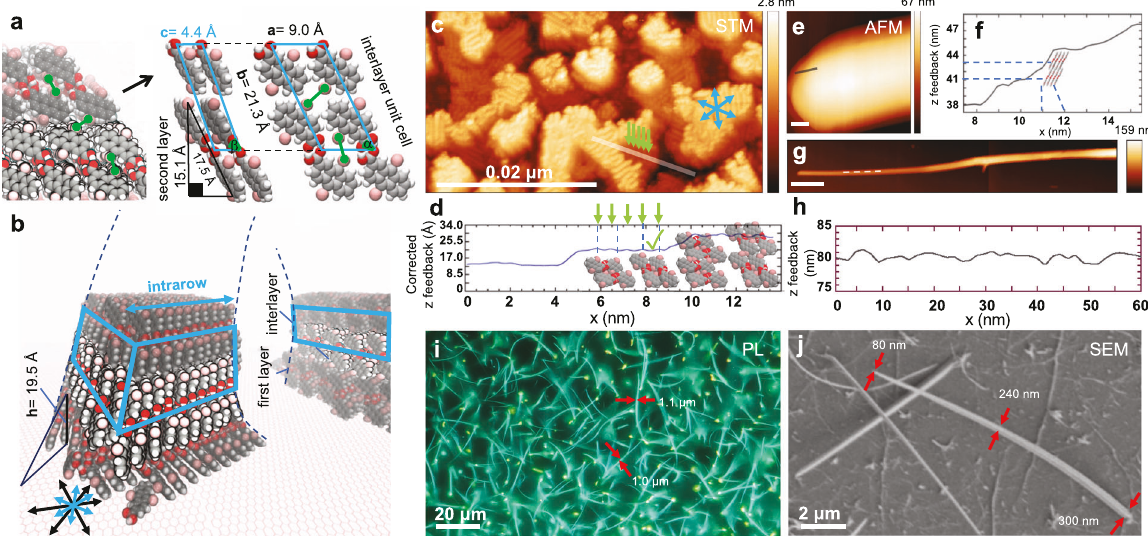
Fig. 3 Simulations, analysis and ultraviolet irradiation of supramolecular nanowires. a A simulated interlayer ( 1 ) 2 – ( 1 ) 2 unit cell on top of the fi rst-layer and, b overview of ns-long molecular dynamics at 350 K depicting nanowire pillars on hexagon-boron nitride (BN). Molecules loosely adsorbed on the substrate have been removed for clarity. The cyan boxes depict the interlayer region supercells, and the intrarow direction (blue arrow) is shown perpendicular to the substrates ’ high symmetry directions (black arrows). c Ultra-high vacuum scanning tunnel microscopy (UHV STM) data at ~20 K of islands of 1 after 30 min multilayer deposition on BN/Cu(111). The blue arrows depict the row directions. d The apparent height pro fi le along two strata in c . Standing ( 1 ) 2 dimers on the substrate are shown to scale. The rows are independent of each other and the average interrow separation (green arrows) is <1 nm, similar to the interrow parameter in Fig. 2. STM parameters I t = 80 pA, V s = 800mV. e , g Atomic force microscopy (AFM) detail of tip of a nanowire after 60 min multilayer deposition on BN/mica. The scale bars in e and g are 7 nm and 50 nm, respectively. f The pro fi le of e depicts eight stacked ( 1 ) 2 shown to z-scale and ~2 nm height variations along the wire. h The pro fi le of g depicts ~2 nm height variations along the wire. i Photoluminescence (PL) ( λ ex = 350 nm) microscopy showing supramolecular nanowires after 60 min multilayer deposition on BN/mica and corresponding diffraction-limited widths (red arrows). j Scanning electron microscopy of the structures after ultraviolet (UV) irradiation, cf. structures before irradiation Supplementary Fig. 7. SEM parameters 1 kV, I = 10 μ A.